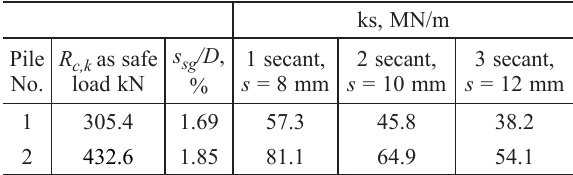
Table 7. Pile stiffness obtained from the analytical load settlements’ curve according to the German Code DIN 1054 (2010)